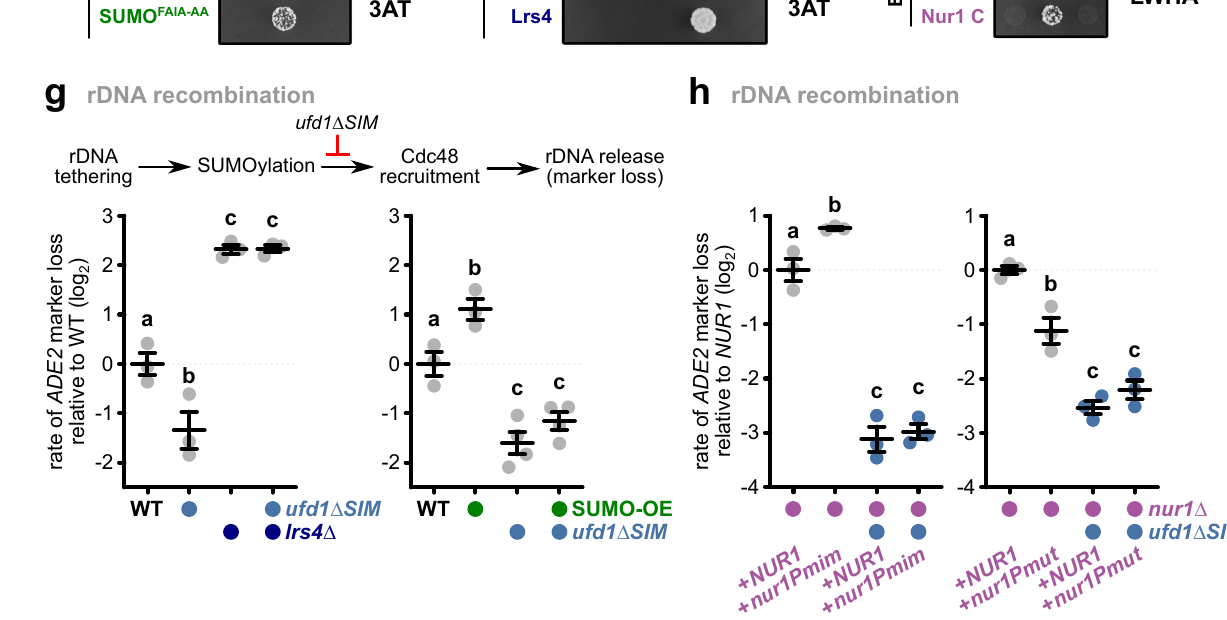
metic nur1Pmim mutant promoted rDNA recombination, this increase in marker loss was blocked when nur1Pmim was combined with ufd1 Δ SIM (Fig. 6h, left). Conversely, cells de fi cient in Nur1 phosphorylation ( nur1Pmut ) that show reduced recombination rates displayed a non-additive phenotype in combination with the ufd1 Δ SIM mutation (Fig. 6h, right). stream of Nur1